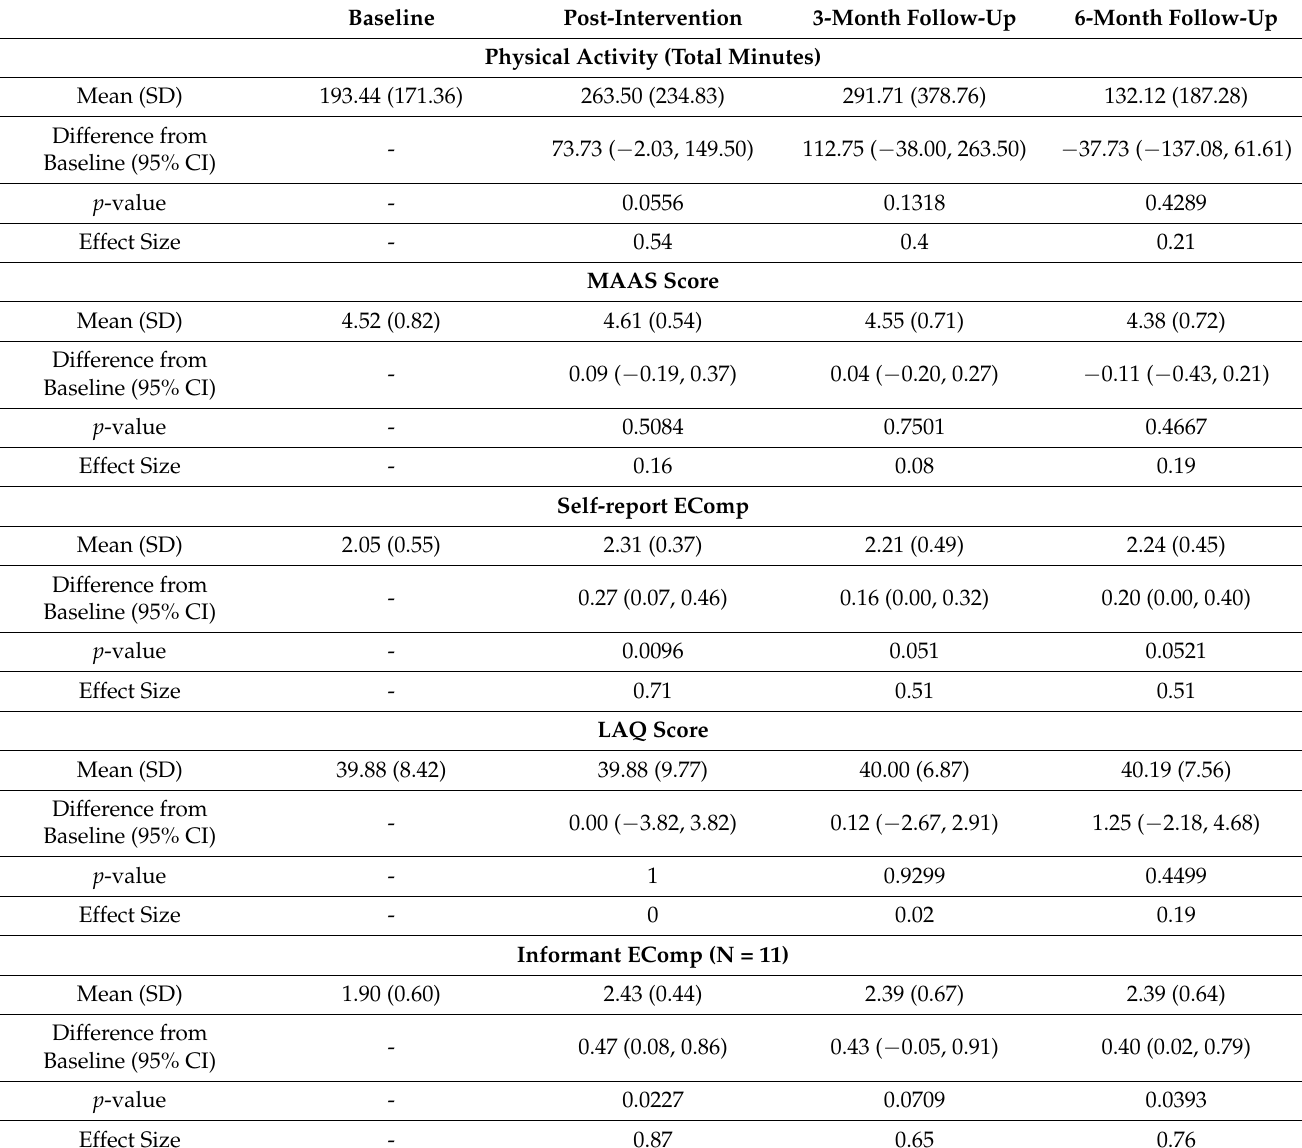
Table 2. Self and informant-reported outcomes on the primary measures at all timepoints. All active participants (coaching and self-implementation) combined (N =